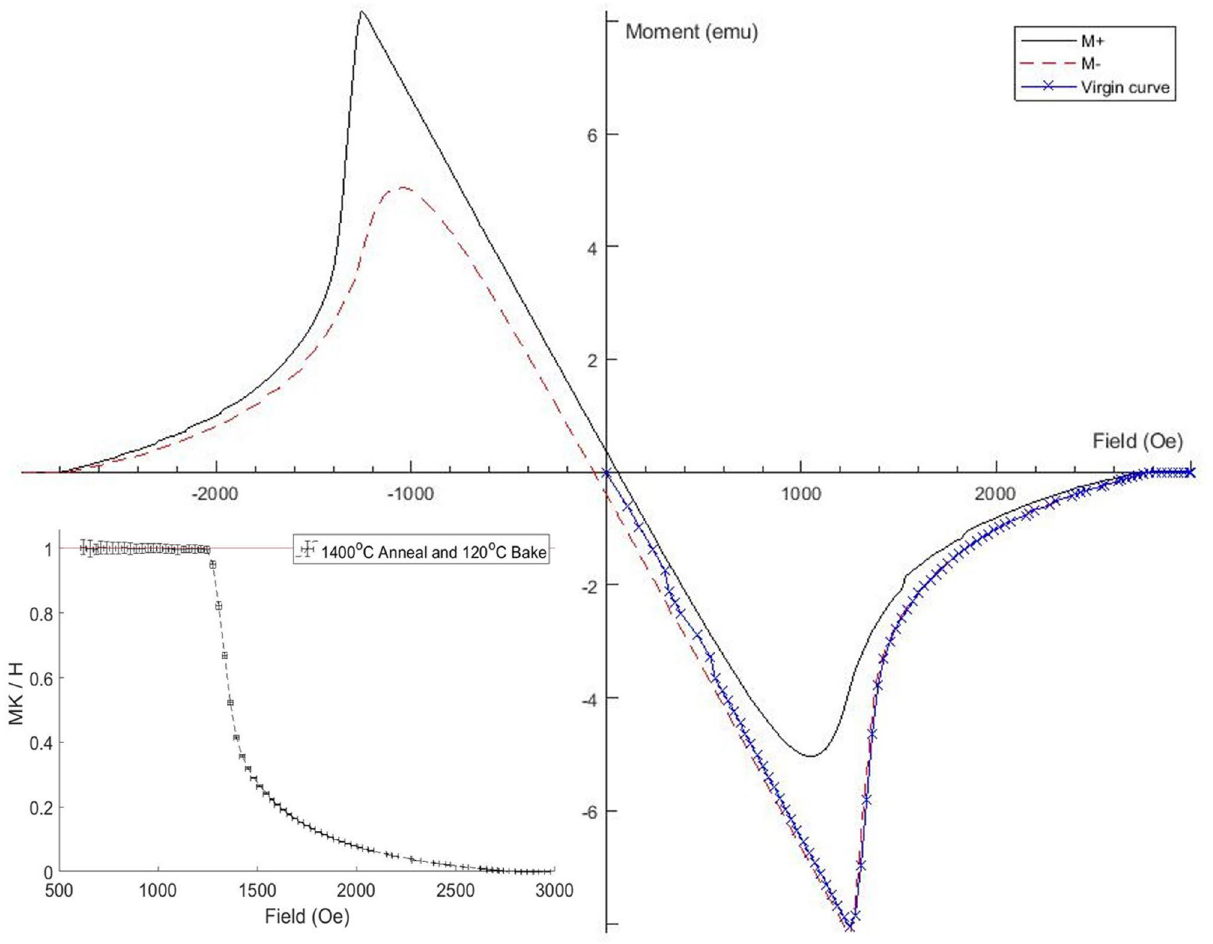
◦ Figure 1. Hysteresis loop for the 120 C baked ellipsoid. The initial increase and decrease in the externally applied field is known as the virgin curve, shown in blue. The positive and negative moment used to determine pinning strength are shown in red and black. The standardisation curve used to determine H vp is shown in the bottom left quadrant, which is determined using the virgin curve. The last point within error of 1 is taken as H vp